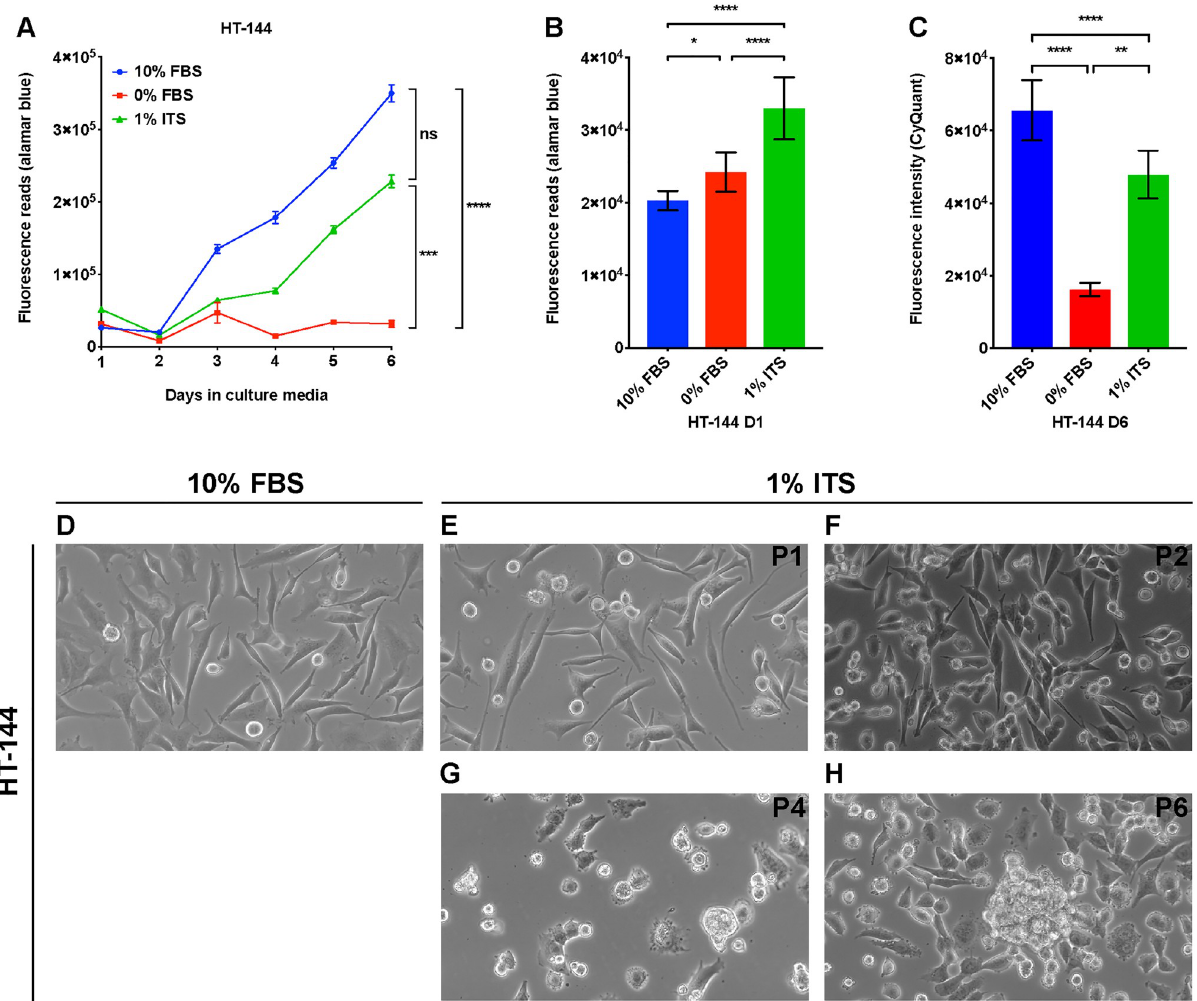
Fig 1. A lipid-free and insulin-supplemented medium supports proliferation of HT-144 melanoma cells. (A) HT-144 cells were seeded in 10% FBS medium at day zero. On day one, cells were washed with PBS and changed to the indicated medium conditions. Cell proliferation was measured with alamarBlue assay daily for six days. Each data point represents the mean ± SD of quadruplicate samples. The results were analyzed using two-way repeated measures ANOVA followed by post hoc Tukey’s multiple comparison tests. For culture time, F = 1505, P < 0.0001; for culture condition, F = 2153, P < 0.0001; for interaction between culture time and condition, F = 409.4, P < 0.0001. (B) HT-144 cells were seeded in 10% FBS medium at day zero. On day one, cells were washed with PBS and changed to the indicated medium conditions. alamarBlue assay was performed on the cells cultured in the indicated medium for one hour. Results were analyzed using one-way ANOVA followed by post hoc Tukey’s multiple comparison tests. F = 202.7. Significant differences between medium conditions are indicated as � P < 0.05, �� P < 0.01, ��� P < 0.001 and ���� P < 0.0001. ns, not significant. (C) HT-144 cells were seeded in 10% FBS medium at day zero. On day one, cells were washed with PBS and changed to the indicated medium conditions. CyQuant assays were performed on the cells cultured in the indicated medium at day six. Each data bar represents average measurement of five replicate samples. Results were analyzed using one-way ANOVA followed by post hoc Tukey’s multiple comparison tests. F = 80.77, P < 0.0001. Significant differences between medium conditions are indicated as � P < 0.05, �� P < 0.01, ��� P < 0.001 and ���� P < 0.0001. ns, not significant. (D—H) HT-144 cells were cultured in RPMI medium with 10% FBS or 1% ITS supplement for multiple passages. Morphologies of cells cultured in 1% ITS medium from passage one (P1) to passage six (P6) were monitored by light microscopy with 40 × objective and 10 × ocular lens.